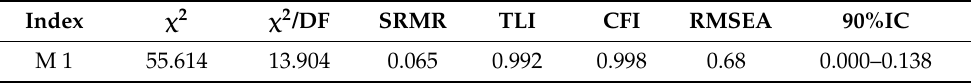
Table 4. Adequacy indexes of the model tested between 12 and 47 months.